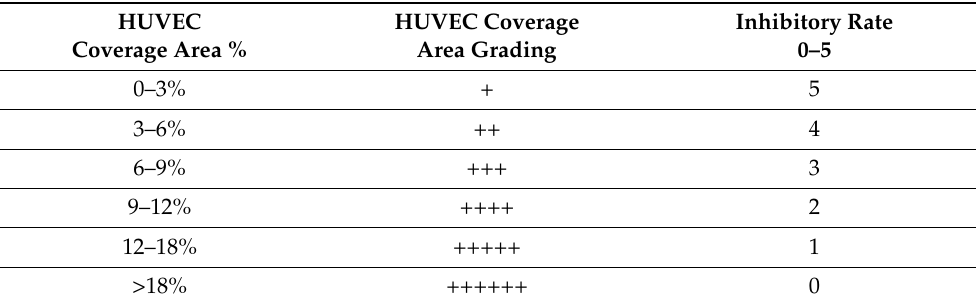
Table 3. Grading of results based on the percentage of area covered by HUVECs. To evaluate the effect of the inhibitors, both the percentage of area covered by HUVECs and their morphology were recorded. Cells that form clusters can still yield high coverage as proliferation is not affected, showing the importance of comparing the quantitative image analysis results with the qualitative results, nor is the morphology. HUVEC HUVEC Coverage Inhibitory Rate Coverage Area % Area Grading 0–5 0–3%